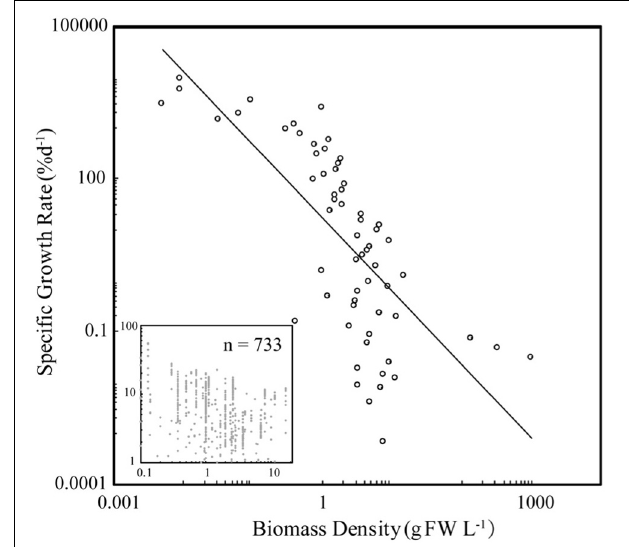
FIGURE 1 | The relationship between specific growth rate (SGR) and biomass density (BD) for seaweed growing under experimental or culture conditions. The closed symbols show the mean values for BD bins of 0.1 g FW L − 1 , for BD < 1 g FW L − 1 , and intervals of 1 g FW L − 1 for greater values, and the insert shows the raw values. The fitted power law for the binned and raw data are SGR = 17.4 BD − 1 . 44 ± 0 . 18 ( R 2 = 0.51, F = 61.96, N = 60, P < 0.001) and SGR = 5.06 BD − 0 . 21 ± 0 . 03 ( R 2 = 0.06, F = 43.3, N = 733, P <